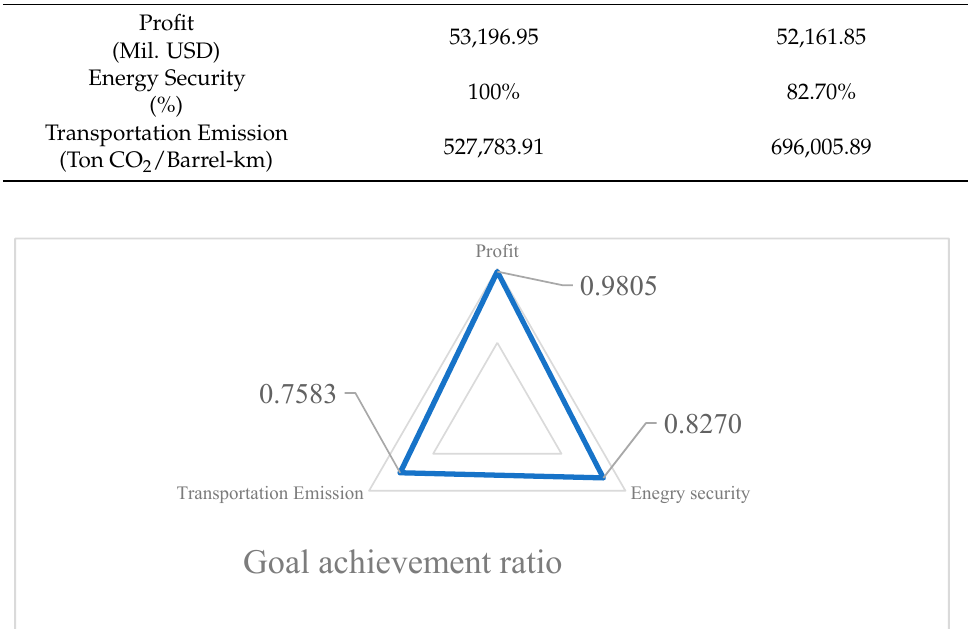
Figure 5. FMMGPM goal achievement ratio.